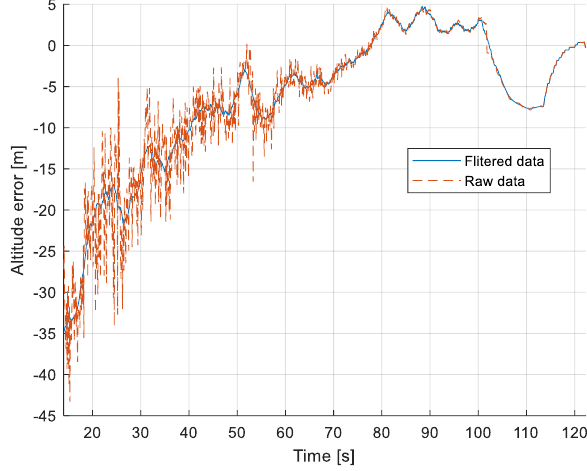
Figure 14. Relative error of altitude measurement using the vision method in relation to the barometric altitude: Flight no. 1.